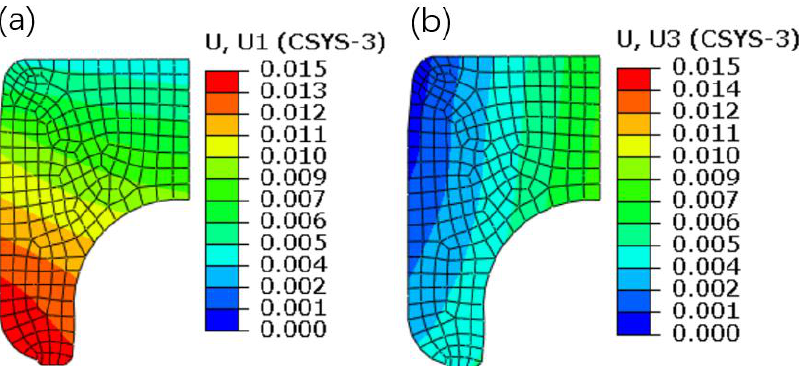
Figure12. Displacementcontourplotsoftheinnerring. ( a )Radialdisplacement. ( b )Axialdisplacement. Figure 12. Displacement contour plots of the inner ring. ( a ) Radial displacement. ( b ) Axial displacement.